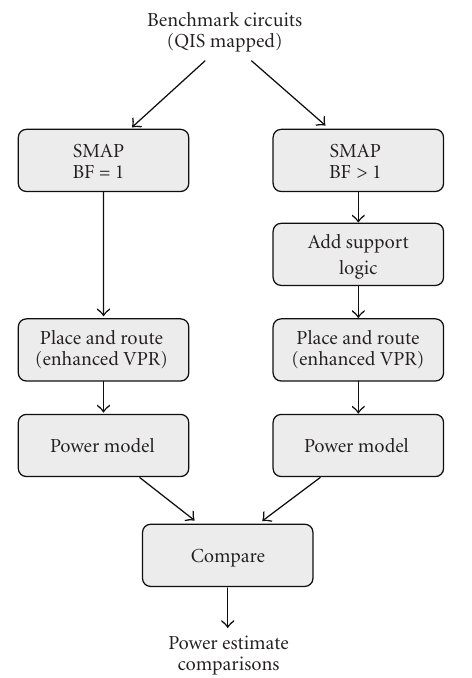
Figure 16: Methodology for evaluating enhanced algorithm.